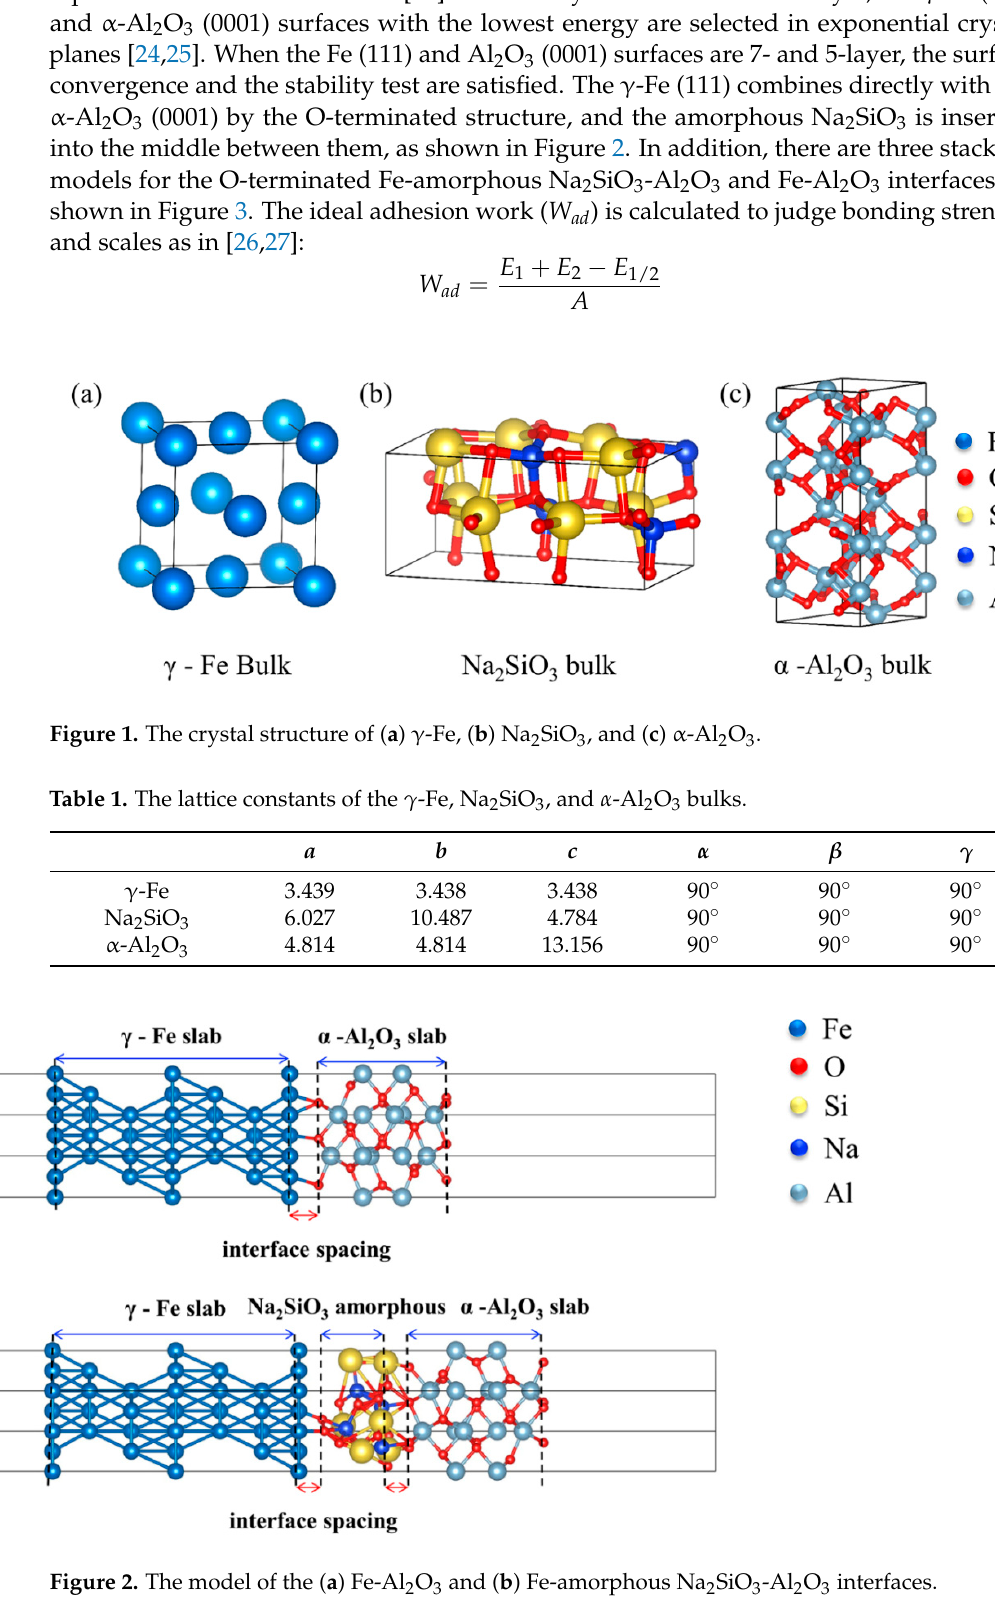
Figure 2. The model of the ( a ) Fe-Al 2 O 3 and ( b ) Fe-amorphous Na 2 SiO 3 -Al 2 O 3 interfaces.